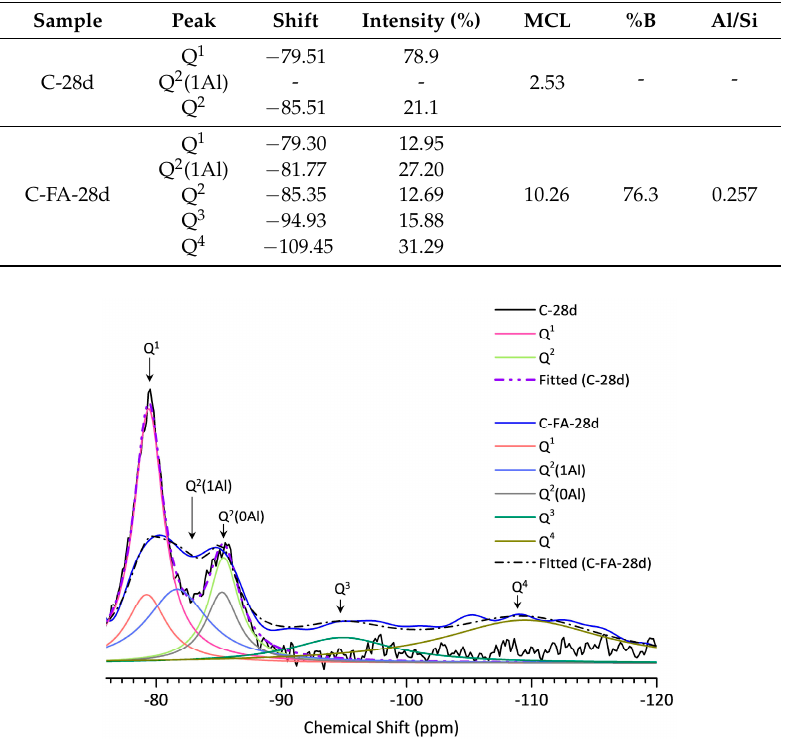
Table 4. Deconvolution results of C-28d and C-FA-28d.